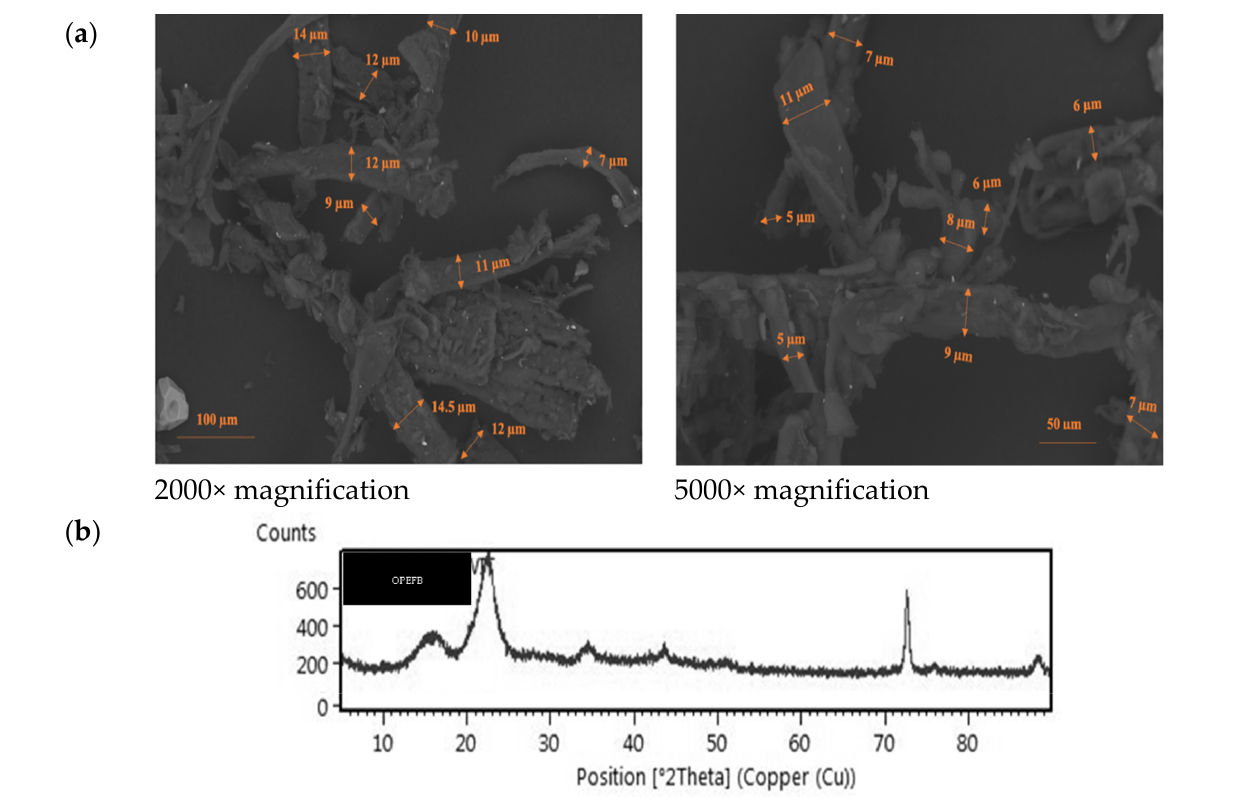
Figure 2. SEM micrograph ( a ) and X-ray Diffraction ( b ) of cellulose microfiber from OPEFB. X-ray Diffraction of CMF-OPEFB.